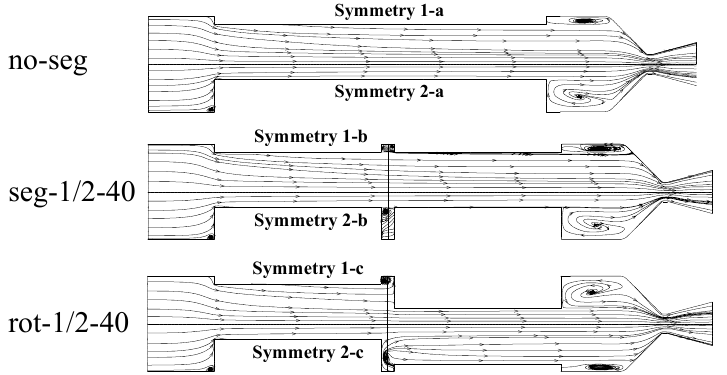
Figure 12. Streamlines of symmetry planes in different cases.